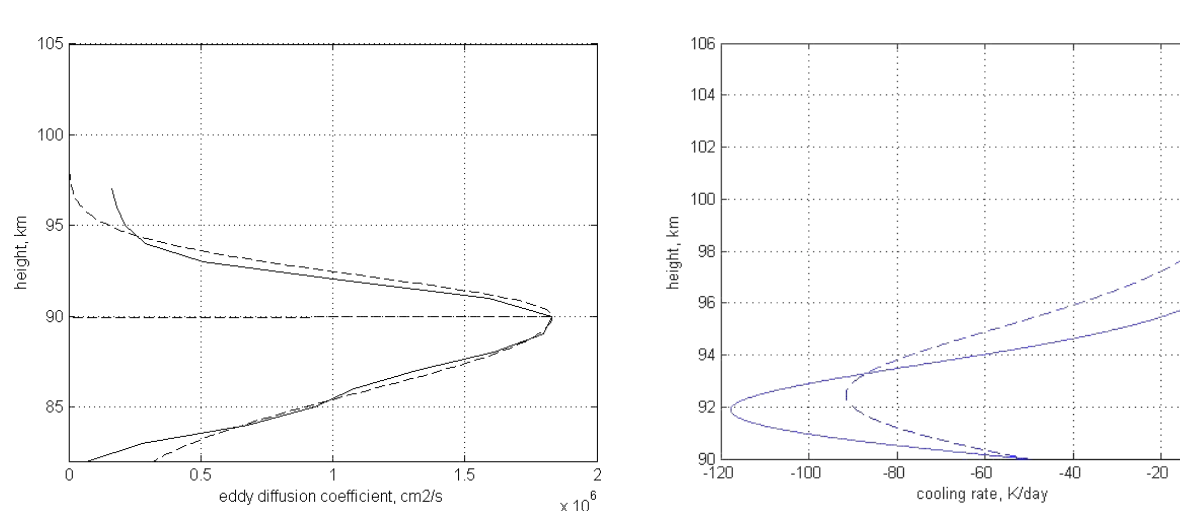
Fig. 10. Height profiles of the cooling rate (solid curve) calcu- lated with the eddy diffusion coefficient shown by a dashed curve ( s = 0 . 1km − 2 ) in Fig. 9 and calculated with s = 0 . 03km − 2 corre- = 1 . 83 × ed sponding to agreement with the cooling rate induced by the eddy diffusion coefficient shown in Fig. 9 below the K ed peak. The straight line shows this